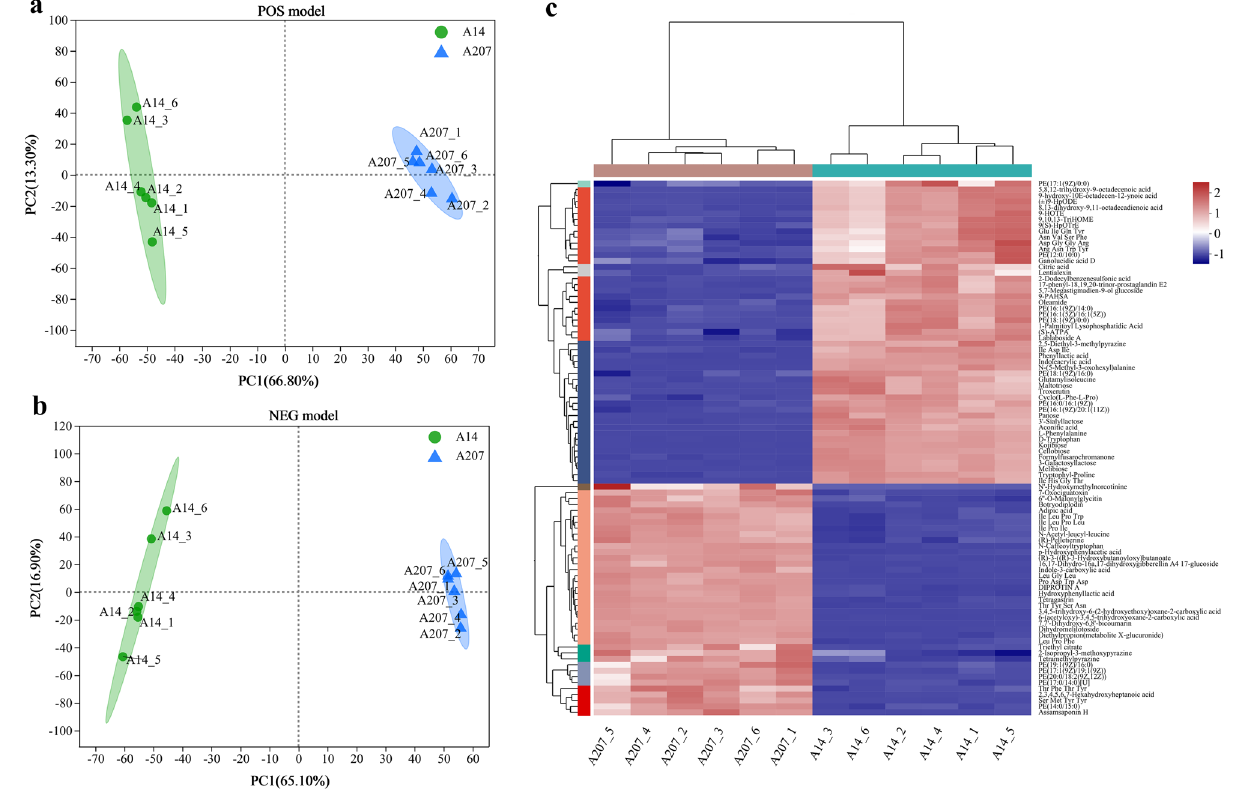
Figure 2. ( a , b ) PCA scores plot of A14 and A207 group in positive model and negative model. ( c ) Top 90 metabolites clustering heatmap of all samples using HCA, the horizontal direction were the samples, and the longitudinal direction were the identified